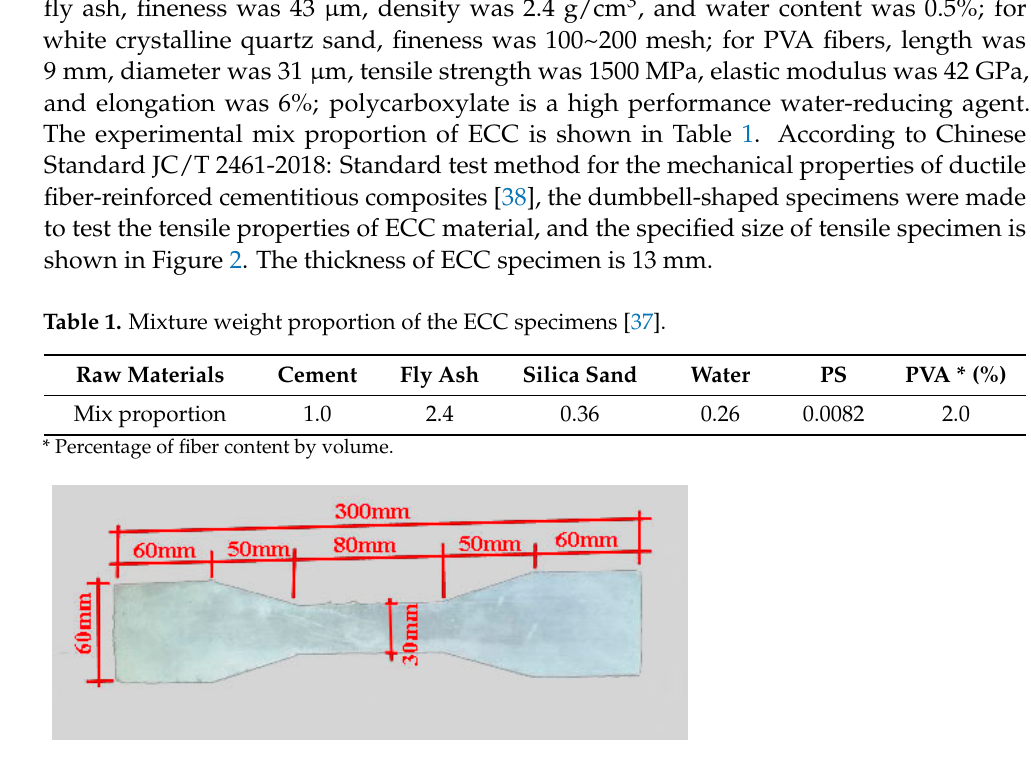
Figure 2. ECC dumbbell-shaped tensile